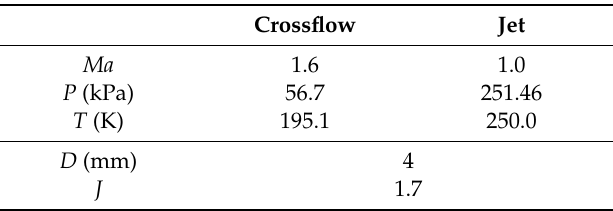
Table 1. Conditions of crossflow and jet in the experiment [24].